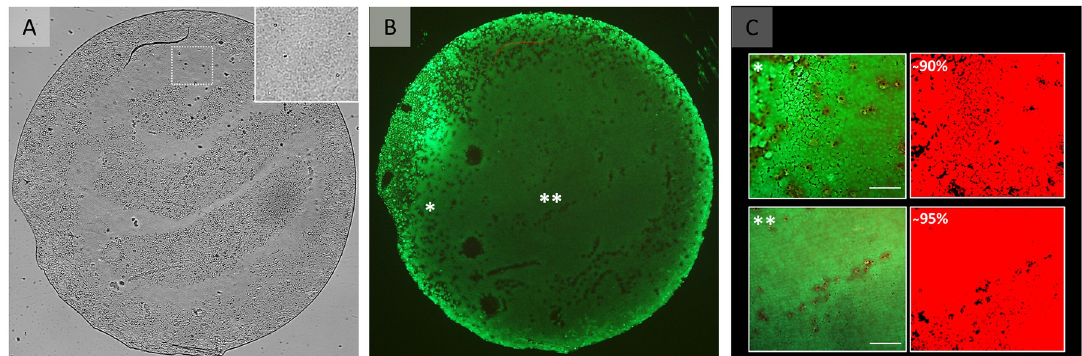
Fig 3. Graft viability after preparation. (A) Light microscopy image of a flattened 4 mm DMEK graft. The insert in the right top corner represents an area on the graft (white square) that may be perceived as a bare area in the overview image but is populated by cells. Please note that areas on the graft that may be perceived as bare areas in are artefacts from the mounting the flat tissue and keeping the graft moist to avoid tissue drying during imaging, which in turn causes some areas to be out of focus. (B) Fluorescence microscopy image of the same graft showing Calcein-AM staining for cell viability. The fluorescence image in (B) shows that all those areas that appeared to be devoid of cells in (A) are indeed covered by viable cells. (C) Higher magnification images from the areas marked by � and �� in overview image (B) to illustrate the viable cells (green) and the corresponding segmentation images (red). Scale bar: 100 μ